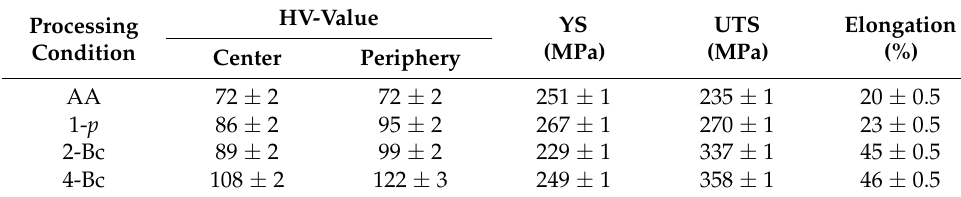
Table 3. Mechanical properties of AA2011 processed via ECAP at 150 ◦ C.